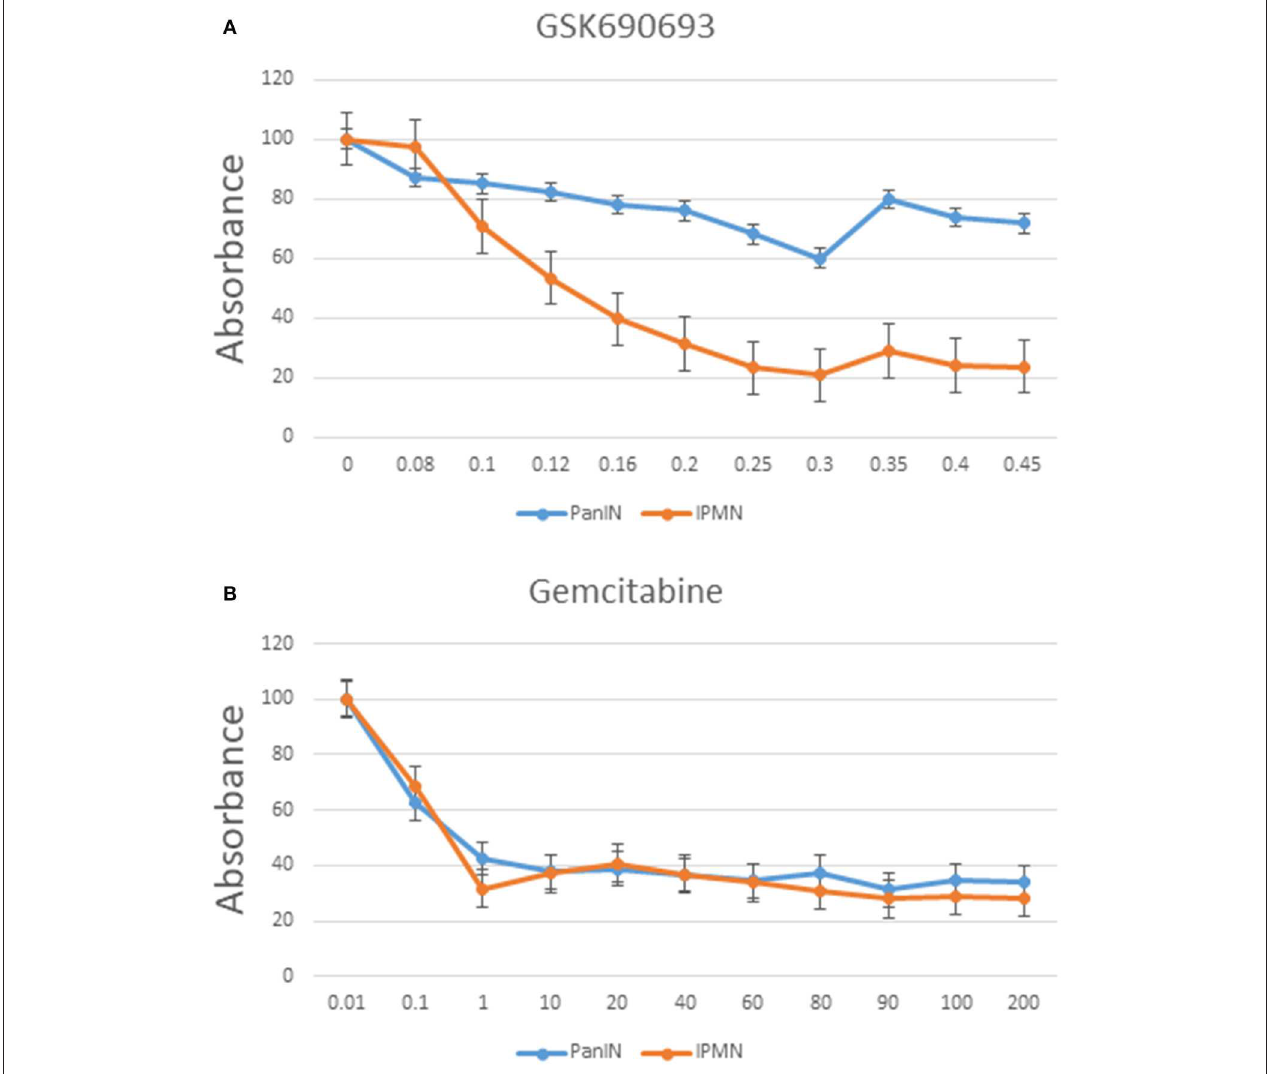
FIGURE 7 | Cell proliferation assay of PanIN and IPMN cells after adding GSK690693 (Akt inhibitor) (A) and gemcitabine (B) normalized to relative control. Data are shown as mean ± SD performed in triplicate, representative of three independent experiments. Y axis: %; x axis: µ M.